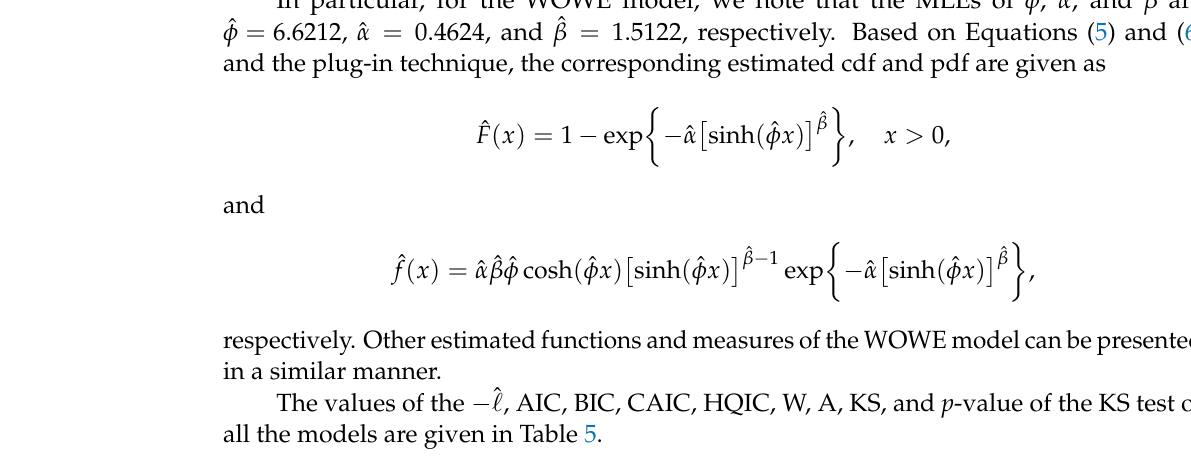
Table 5. Fit measures for the drilling machine data.